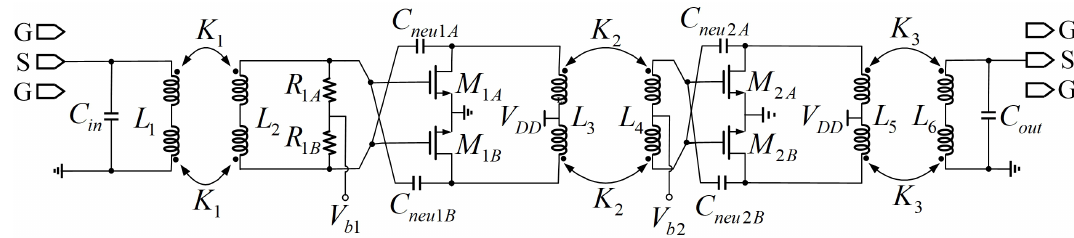
Figure 1. Schematic of the two-stage transformer-coupled PA.